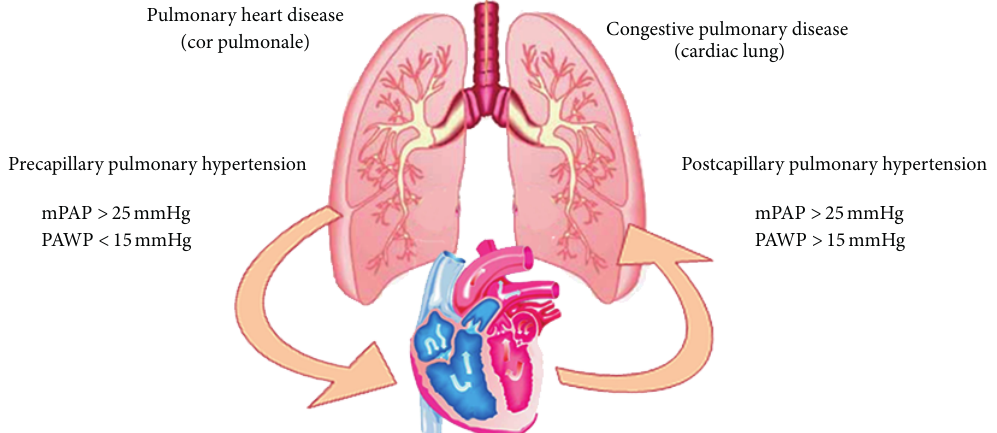
Figure 1: Physiopathology and reference range values in precapillary pulmonary hypertension and postcapillary pulmonary hypertension.